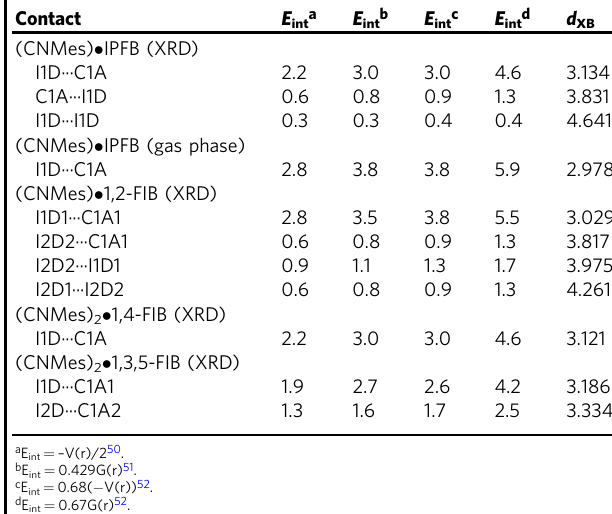
Table 3 Energies ( E int , kcal · mol – 1 ) and separations ( d , Å) for I···C and I···I noncovalent interactions in XB adducts with CNMes de fi ned by different